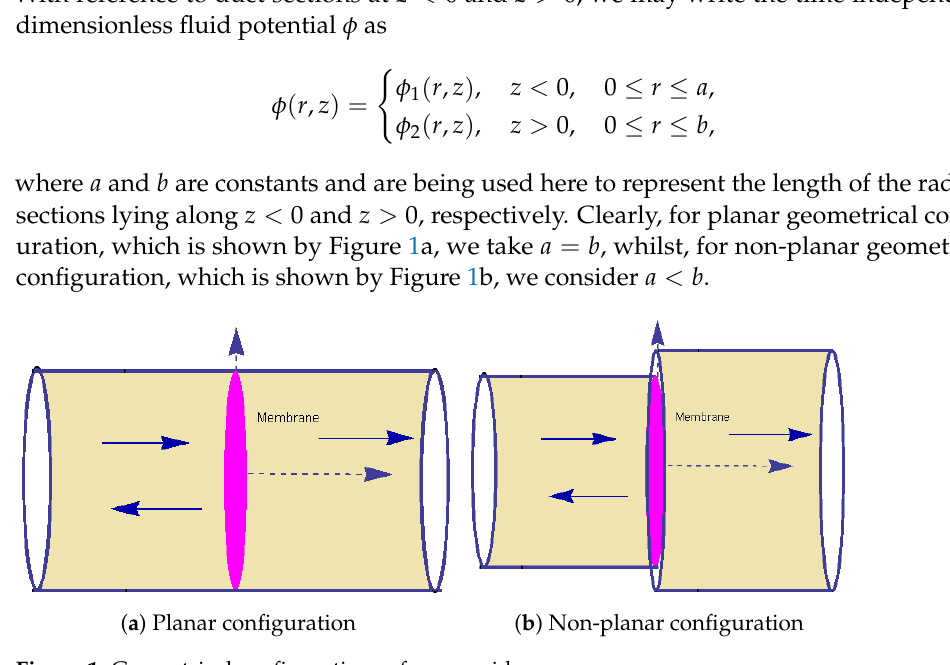
Figure 1. Geometrical configurations of